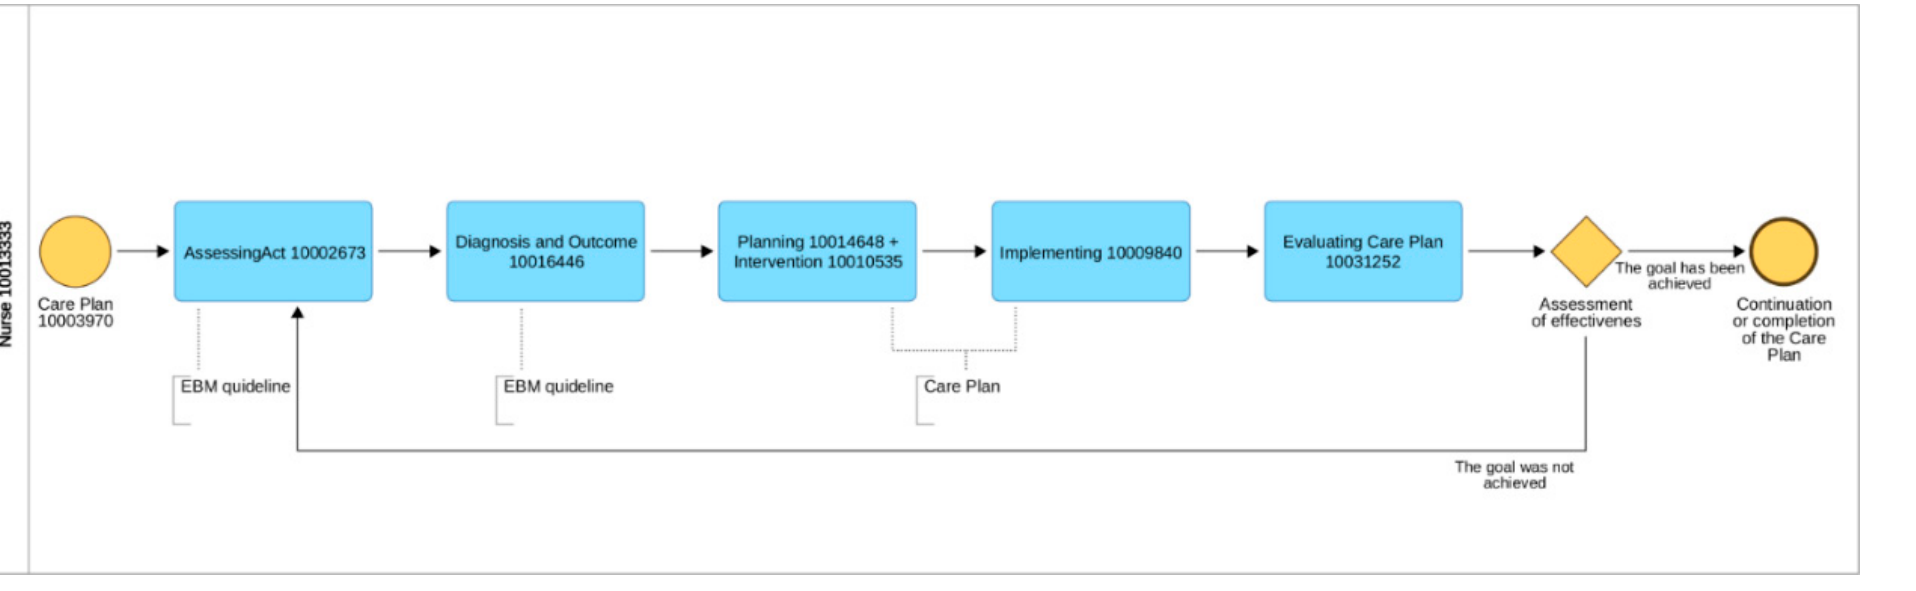
Figure 2. The BMN clinical path—the nursing process in client/patient education . Source: BPMN ed. Kami ń ski M., Kila ń ska D., Lipi ń ski C., Librowska B.,